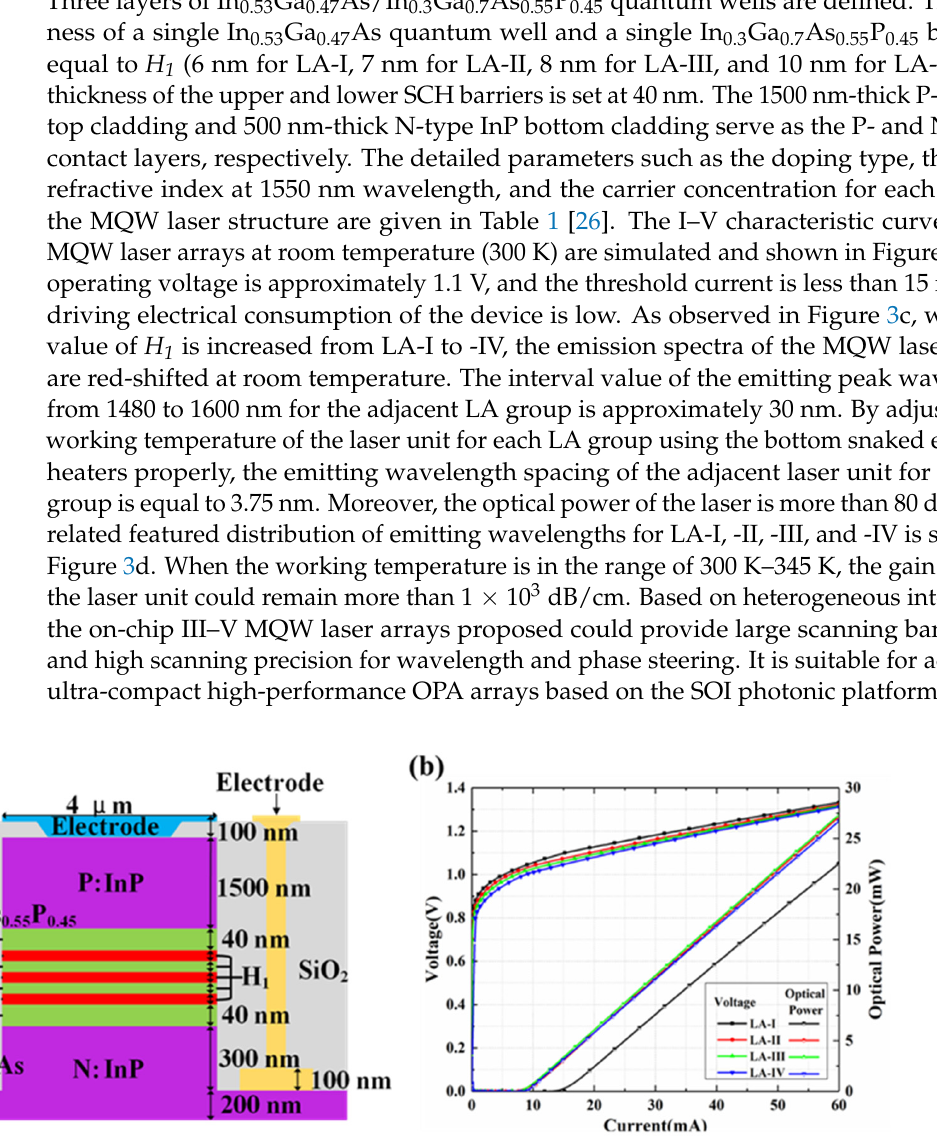
Figure 2. The structure of integrated laser arrays on the chip. ( a ) The overall structure of laser arrays. ( b ) The top view of the F-P MQW laser. ( c ) The cross-section of the F-P MQW laser. ( d ) The temper- ature-control electrode layout scheme of LA-I.